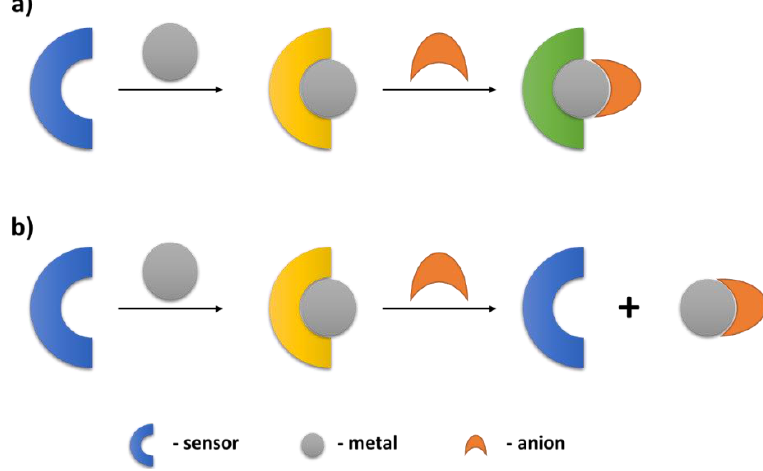
Figure 1. Two approaches for anion sensing: ( a ) sequential; and ( b ) displacement.